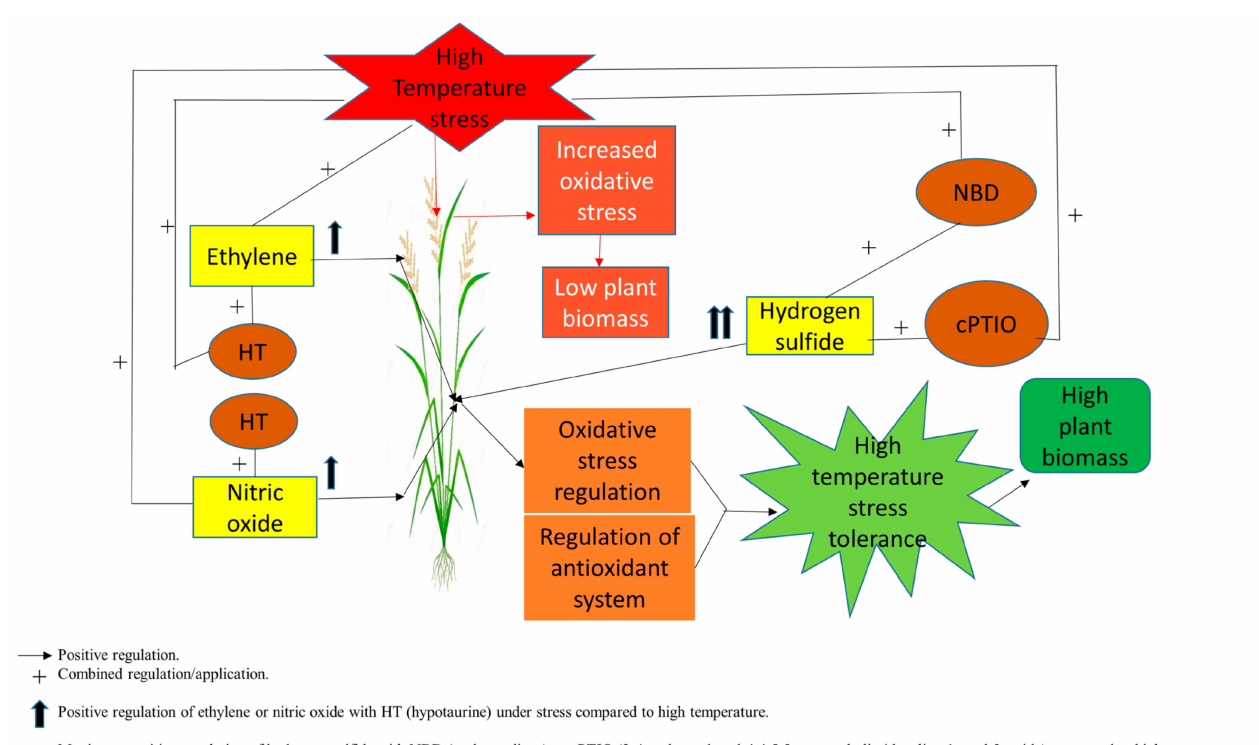
Figure 8. Proposed model for the role of ethylene, NO and H 2 S in the alleviation of high tem- perature stress in rice ( Oryza sativa L.) NBD; norbornadiene, cPTIO; 2-4-carboxyphenyl-4,4,5,5- tetramethylimidazoline-1-oxyl-3-oxide, HT;